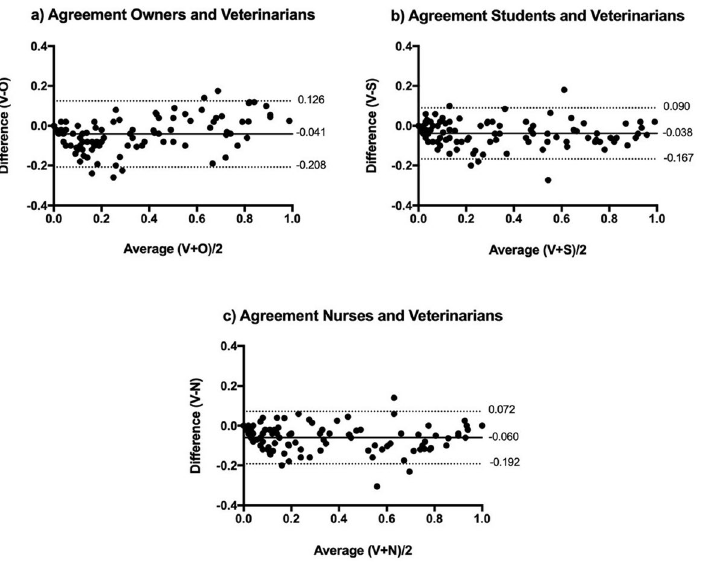
Figure 4. Bland and Altman plots showing the agreement of the Feline Grimace Scale scores between each group and the veterinarian group, considered as the gold standard. ( a ) Agreement between cat owners (O) and veterinarians (V). ( b ) Agreement between veterinary students (S) and veterinarians (V). ( c ) Agreement between veterinary nurses (N) and veterinarians (V). The bias (central continuous line) and limits of agreement (dotted lines) are indicated on each plot (raters: n =